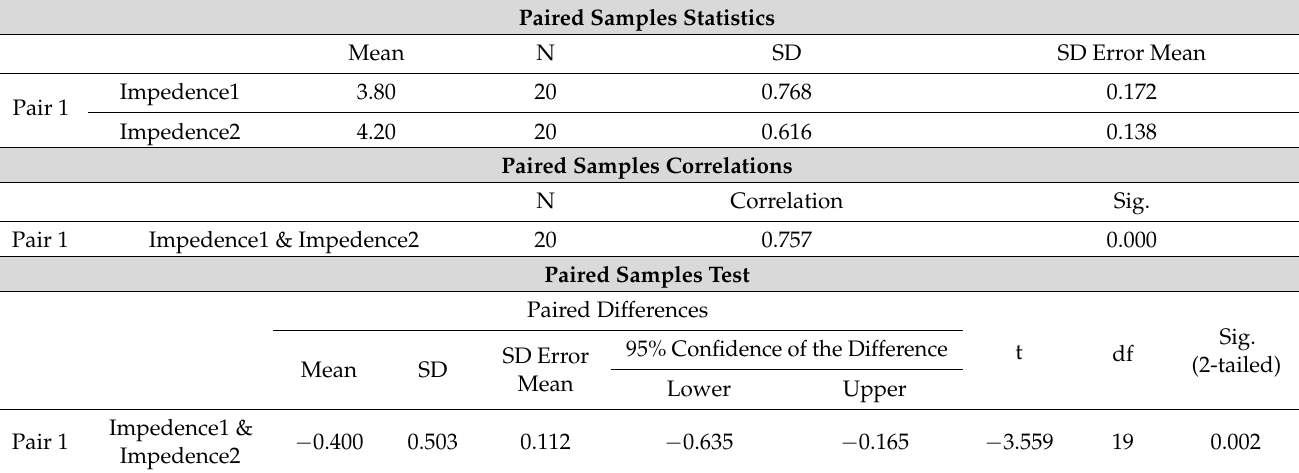
Table 3. T-test results of the comparison between the parameter set 1 and 2.